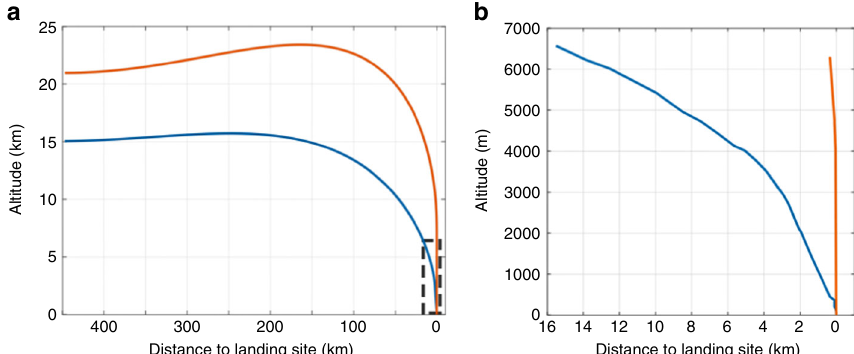
Fig. 7 Comparison of powered descent trajectory between the CE-3 and CE-4. The blue and orange lines represent trajectories of the CE-3 and CE-4, respectively. a The designed trajectories of the entire powered descent, in which the marked rectangle corresponds to designed trajectories below the altitude of ~6 km; b Magni fi ed portion of the reconstructed trajectory below the altitude of ~6 km. Altitude is given with respect to fi nal landing site level